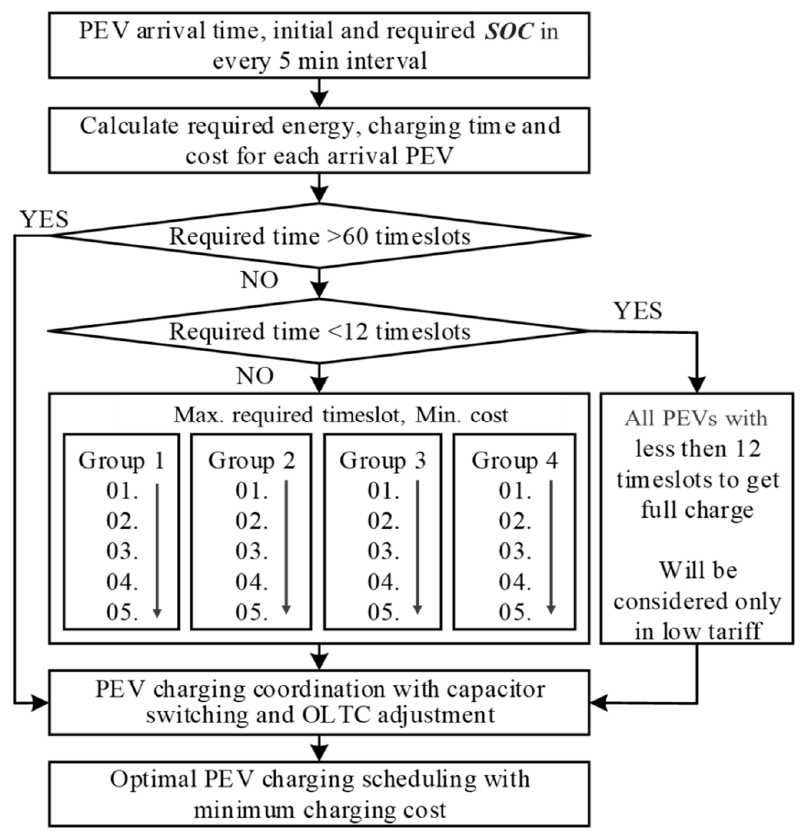
Figure 1. Flowchart of the proposed PEV charging cost minimization strategy.